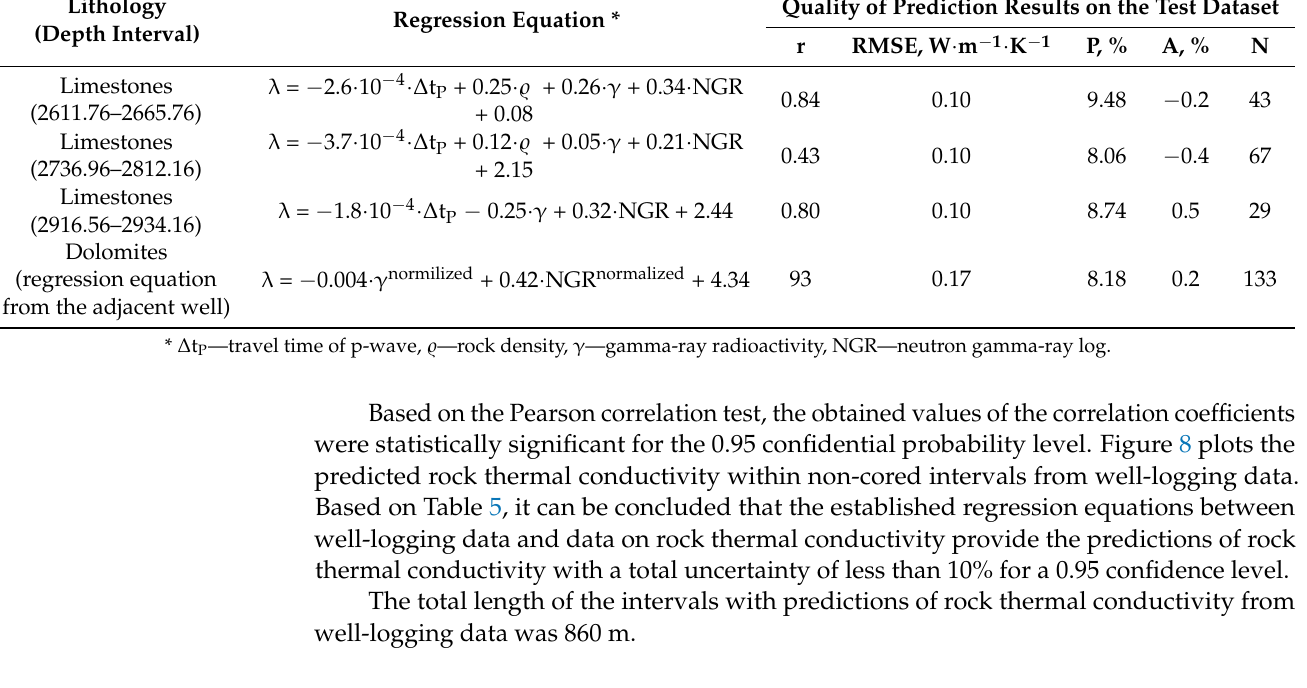
Quality of Prediction Results on the Test Dataset